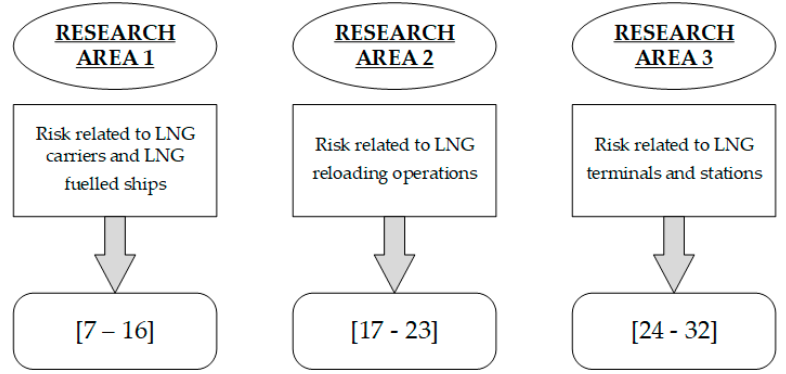
Figure 1. Literature review for research areas—compendium.